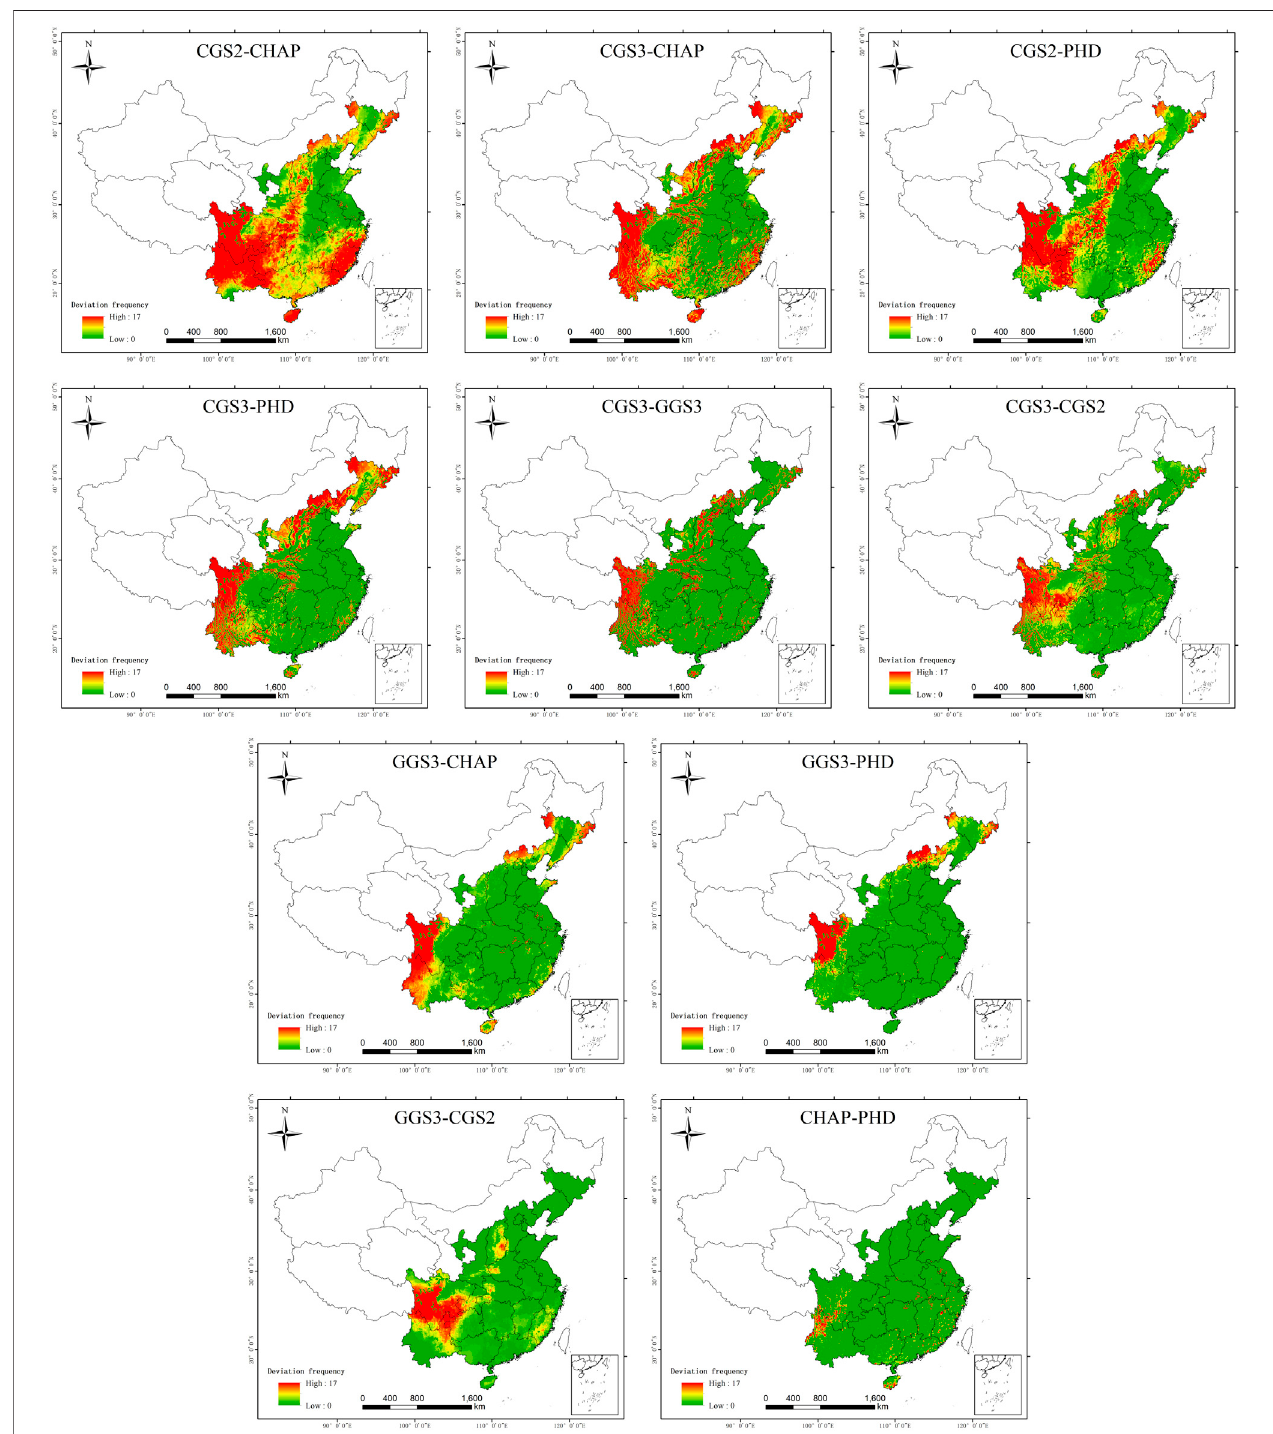
FIGURE 4 | Spatial distribution of deviation frequency in premature deaths assessed by any two PM 2.5 datasets.